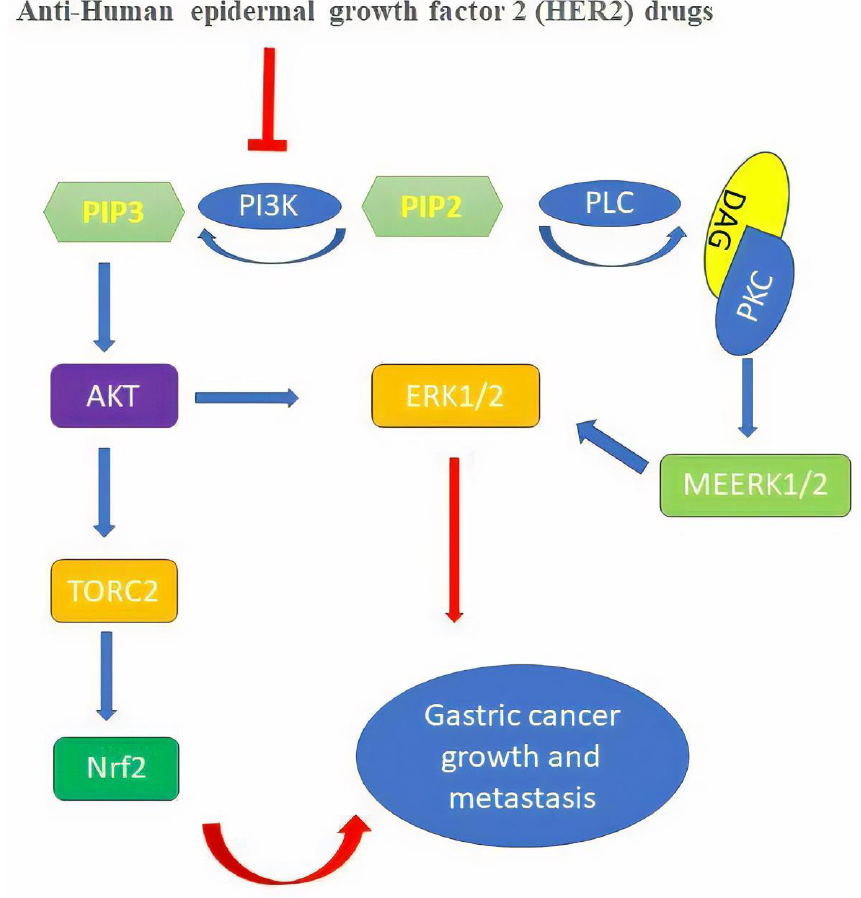
Figure 1. The inhibitory effect of anti-HER2 drugs on Nrf2 inhibition and gastric cancer prevention.